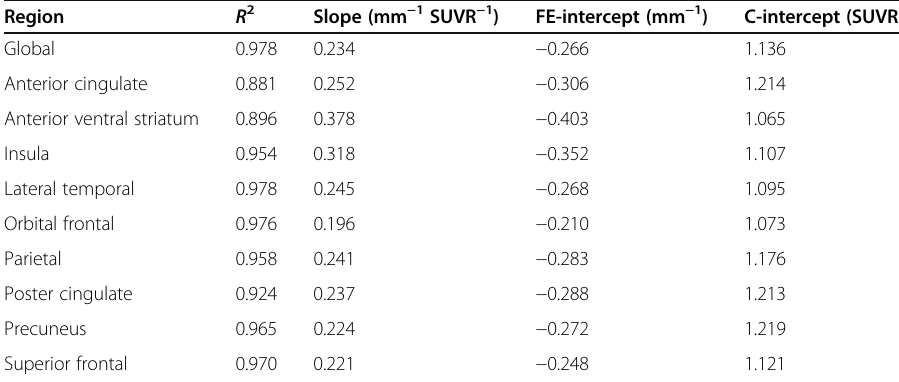
Table 1 Parameters of the linear fits to the data shown in Fig. 2 Region R 2 Slope (mm − 1 SUVR − 1 ) FE-intercept (mm − 1 ) C-intercept (SUVR) Global 0.978 0.234 − 0.266 1.136 Anterior cingulate 0.881 0.252 − 0.306 1.214 Anterior ventral striatum 0.896 0.378 − 0.403 1.065 Insula 0.954 0.318 − 0.352 1.107 Lateral temporal 0.978 0.245 − 0.268 1.095 Orbital frontal 0.976 0.196 − 0.210 1.073 Parietal 0.958 0.241 − 0.283 1.176 Poster cingulate 0.924 0.237 − 0.288 1.213 Precuneus 0.965 0.224 − 0.272 1.219 Superior frontal 0.970 0.221 − 0.248